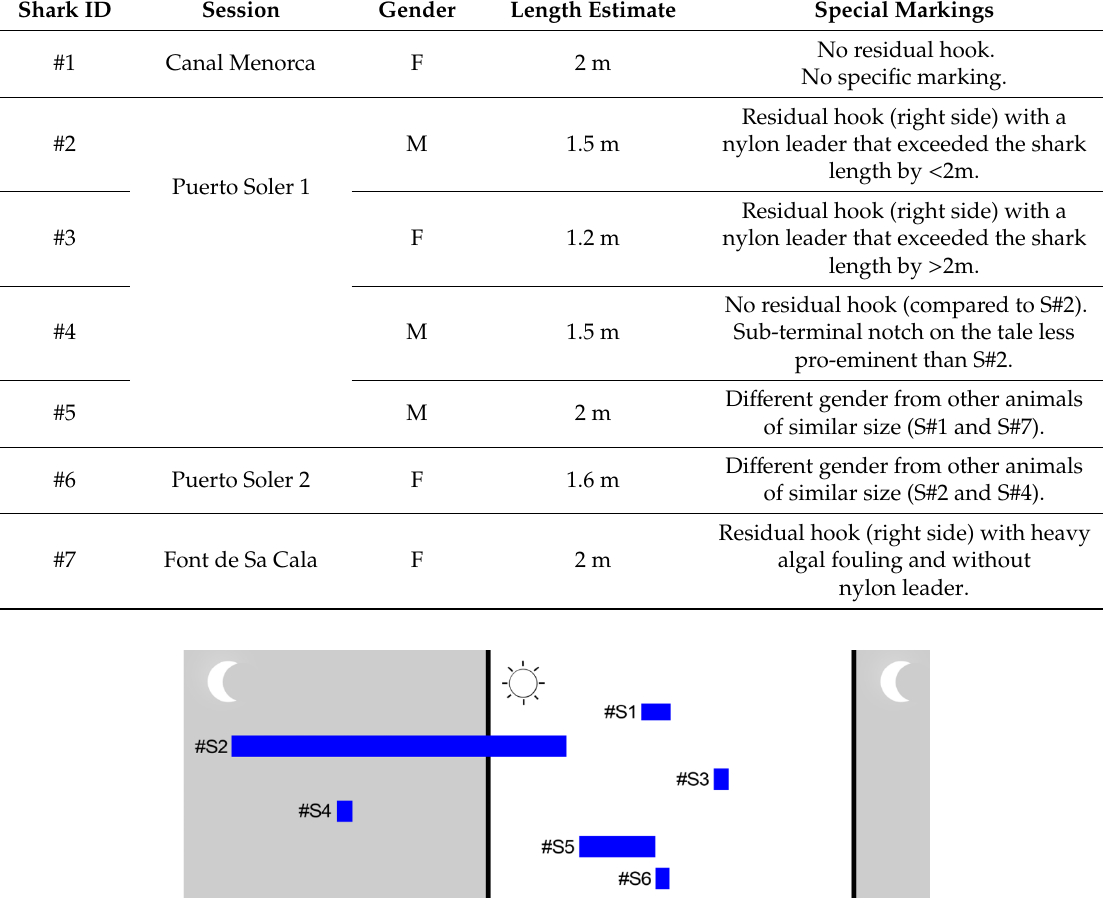
Table 2. Description of the sharks with discriminating parameters.